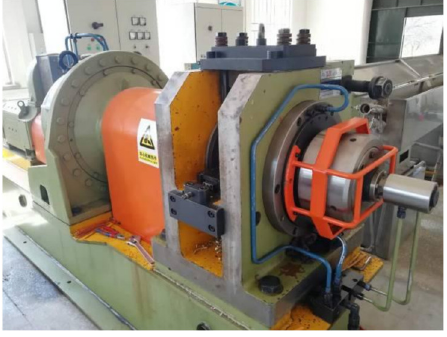
Figure 4. TLJ250 continuous extrusion machine.